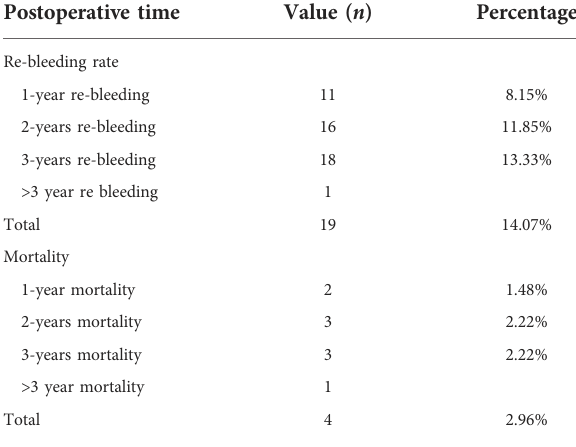
TABLE 4 Rebleeding rate and mortality rate in follow-up ( n